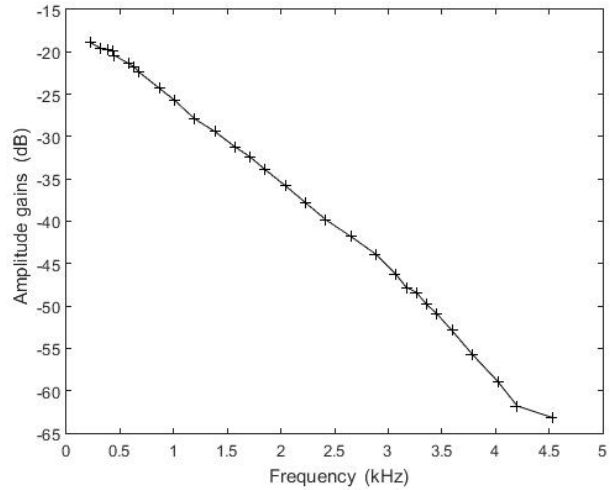
Figure 2. Amplitude–frequency characteristics of varnished wires in